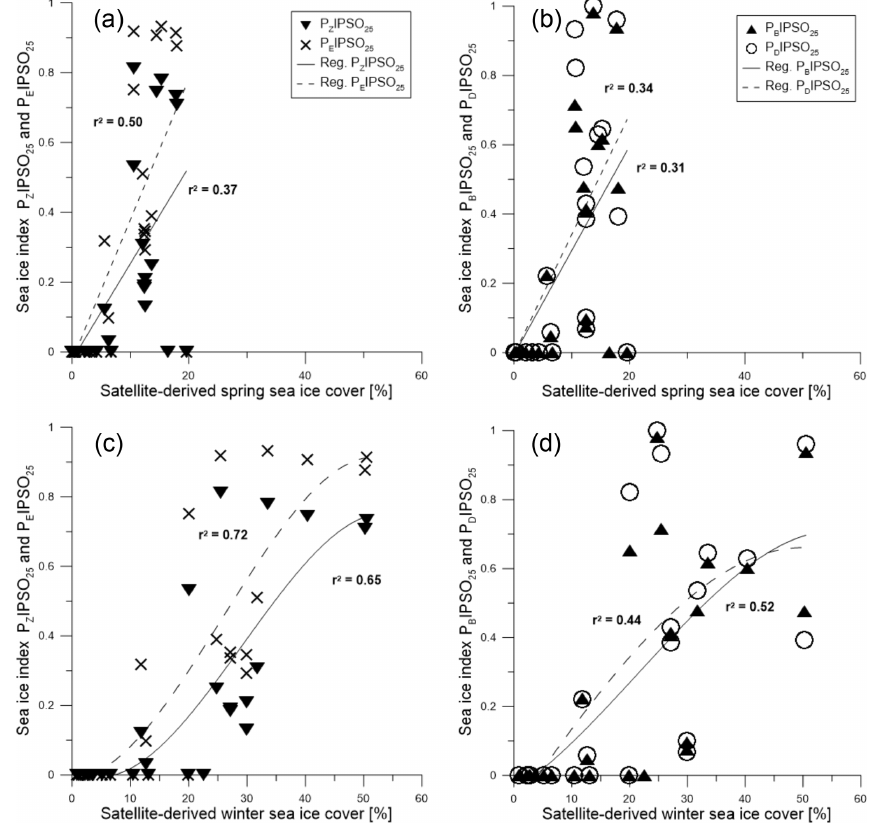
Figure 7. Scatter plots of satellite spring sea ice concentrations and (a) P Z IPSO 25 (triangles, solid regression line) and P E IPSO 25 (crosses, dashed regression line) and (b) P B IPSO 25 (triangles, solid regression line) and P D IPSO 25 (circles, dashed regression line). Scatter plots of satellite winter sea ice concentrations with (c) P Z IPSO 25 (triangles, solid regression line) and P E IPSO 25 (crosses, dashed regression line) and (d) P B IPSO 25 (black triangles, solid regression line) and P D IPSO 25 (circles, dashed regression line). All scatter plots were done with Grapher ™